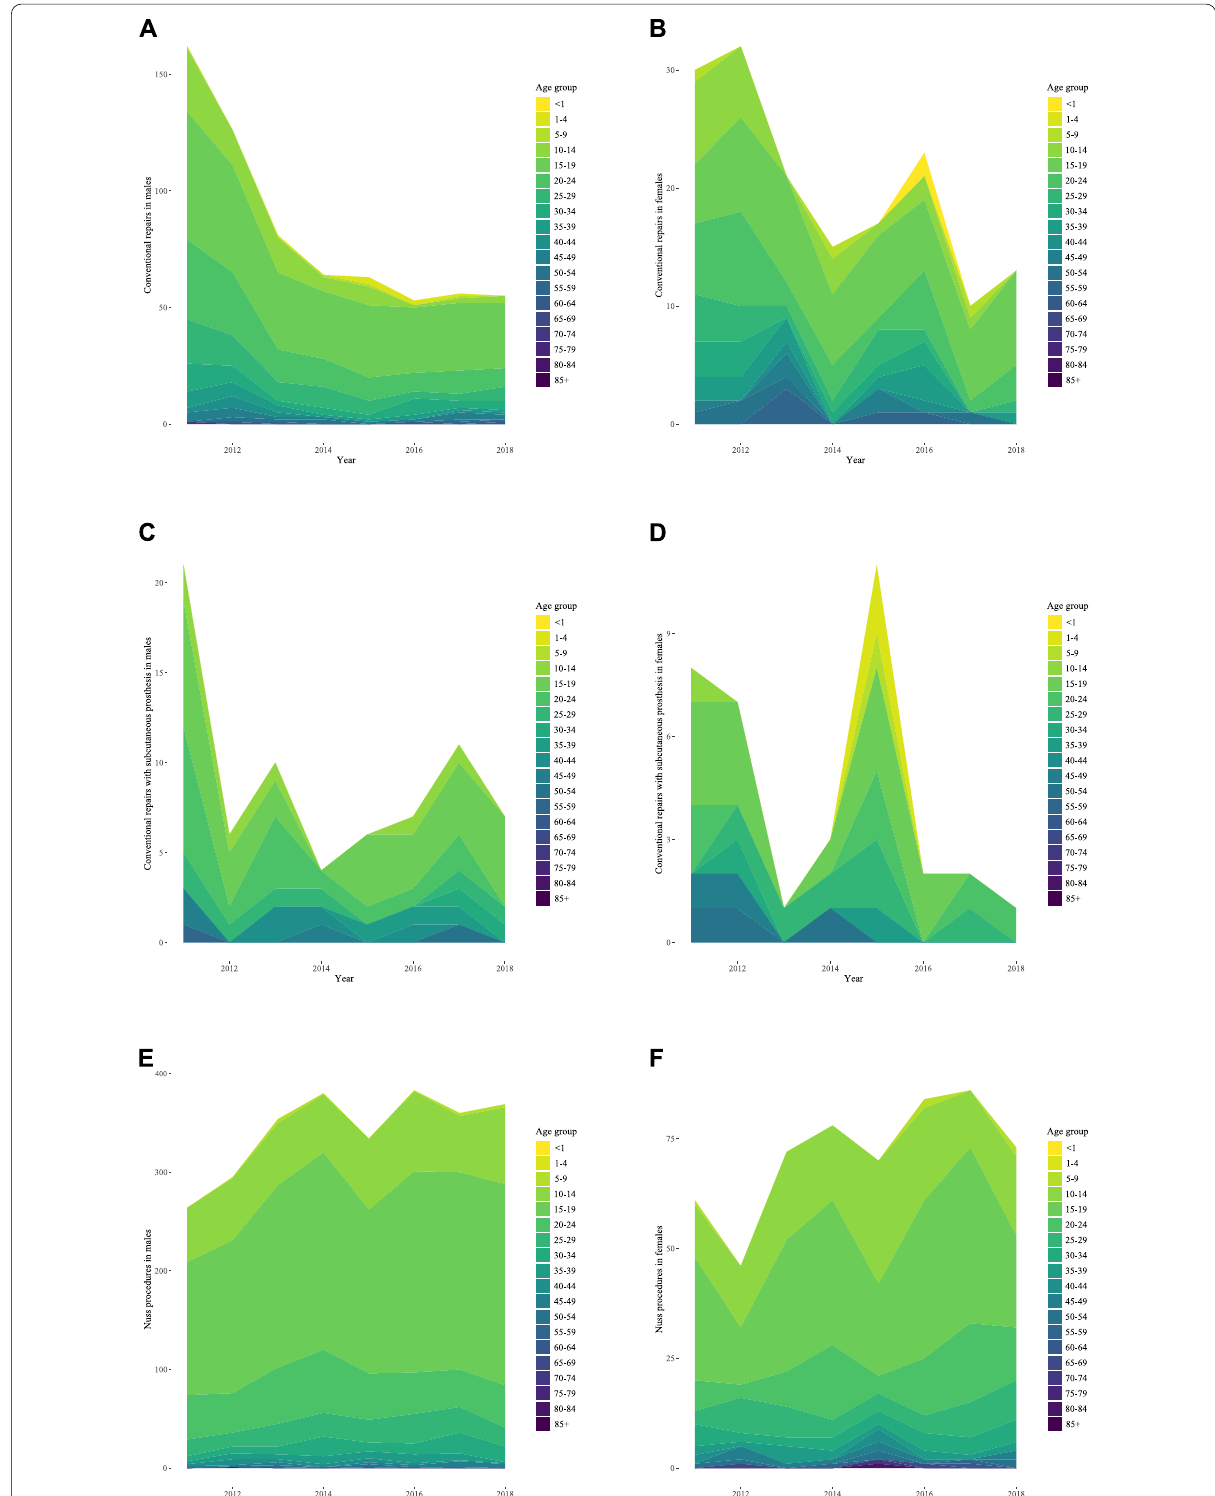
Fig. 1 Number of funnel chest repairs in the German population separated by sex and age. A Conventional repairs in males. B Conventional repairs in females. C Conventional repairs with implantation of a subcutaneous implant in males. D Conventional repairs with implantation of a subcutaneous implant in females. E Nuss procedures in males. F Nuss procedures in